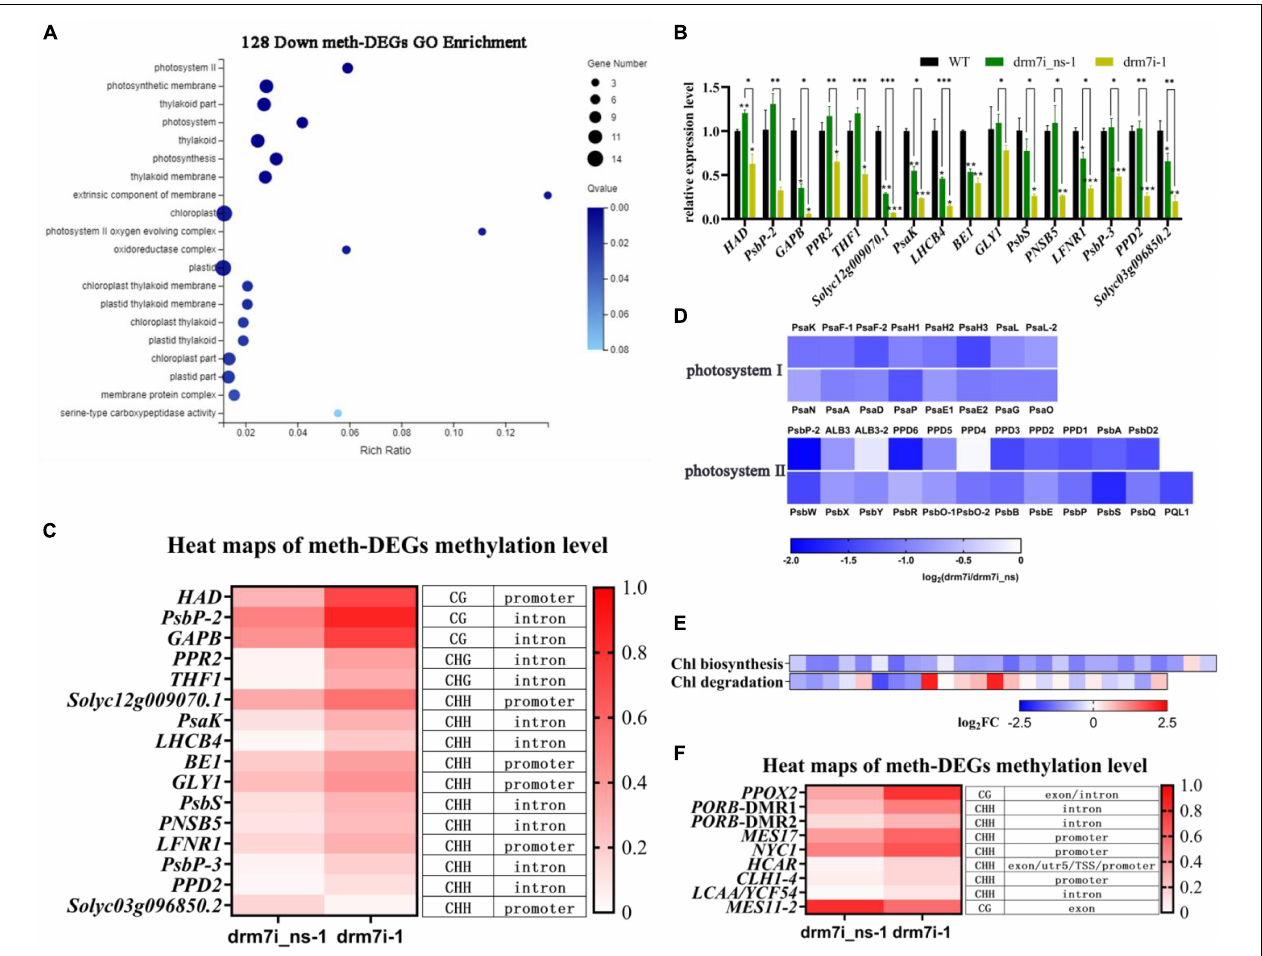
FIGURE 6 | Analysis of down-regulated meth-DEGs. (A) Gene ontology enrichment analysis of 128 downregulated meth-DEGs. The size of the circle represents gene numbers, and the color represents the FDR. (B) Validation of RNA-seq using RT-qPCR for meth-DEGs involved in photosynthetic or chloroplast-related terms in (A) . Data are shown as means ± SD of three biological duplicates. Asterisks (above error bar represent the difference with WT; above the short line represent the difference with drm7i_ns) indicate the significant differences (* P ≤ 0.05, ** P ≤ 0.01, *** P ≤ 0.001, one-way ANOVA, Tukey’s HSD). (C) Heat map illustration of the methylation level of meth-DEGs shown in (B) . (D) Heat map display of gene expression in the photosynthesis light reactions. Gene expression was determined by RNA-seq. (E) Heat map of expression of genes related to chlorophyll biosynthesis and chlorophyll degradation. Gene expression was determined by RNA-seq. (F) Heat map of the methylation levels of meth-DEGs in (E)